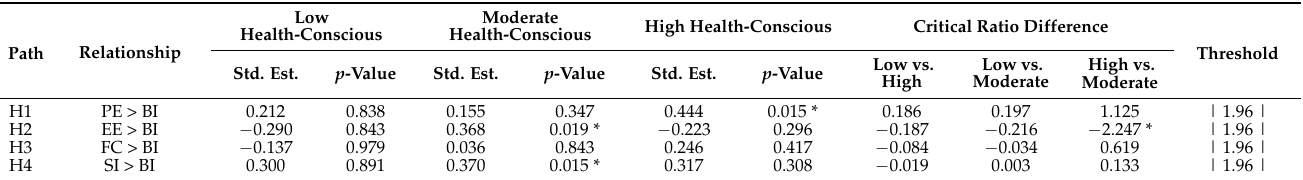
Table 12. Test result from loading